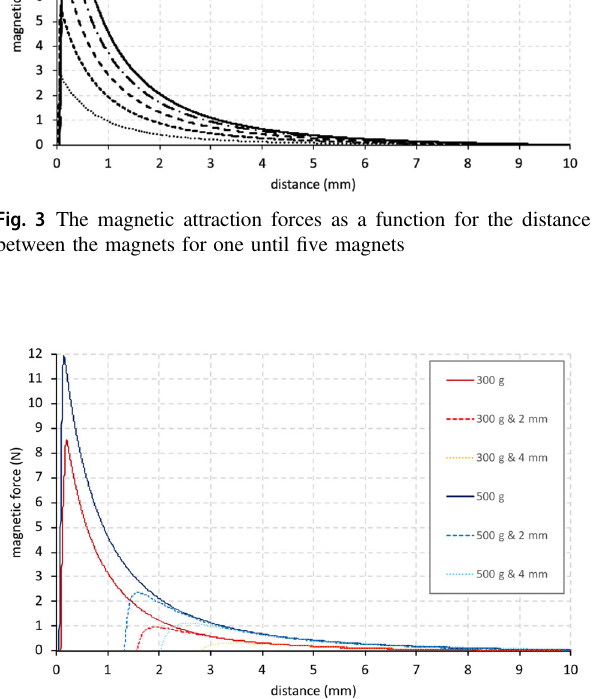
Fig. 4 The magnetic attraction forces for fi ve 300 and 500 gram magnets with either no or 2 mm thick or 4 mm thick porcine rugae